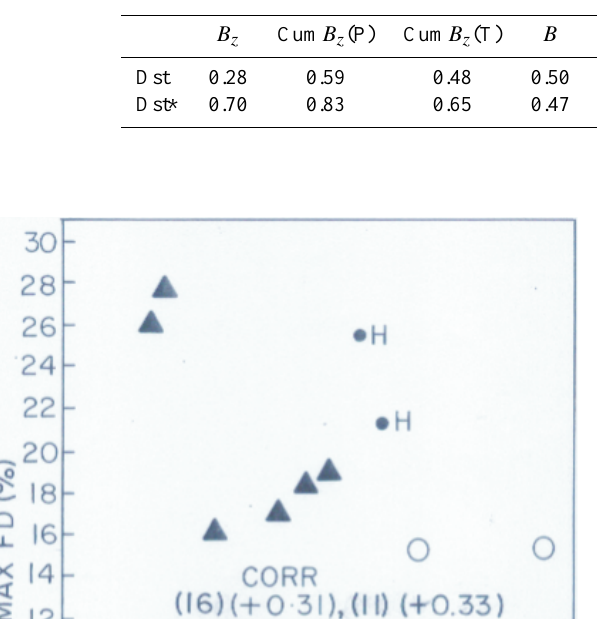
Table 4. Correlations of Dst and Dst* with other parameters.